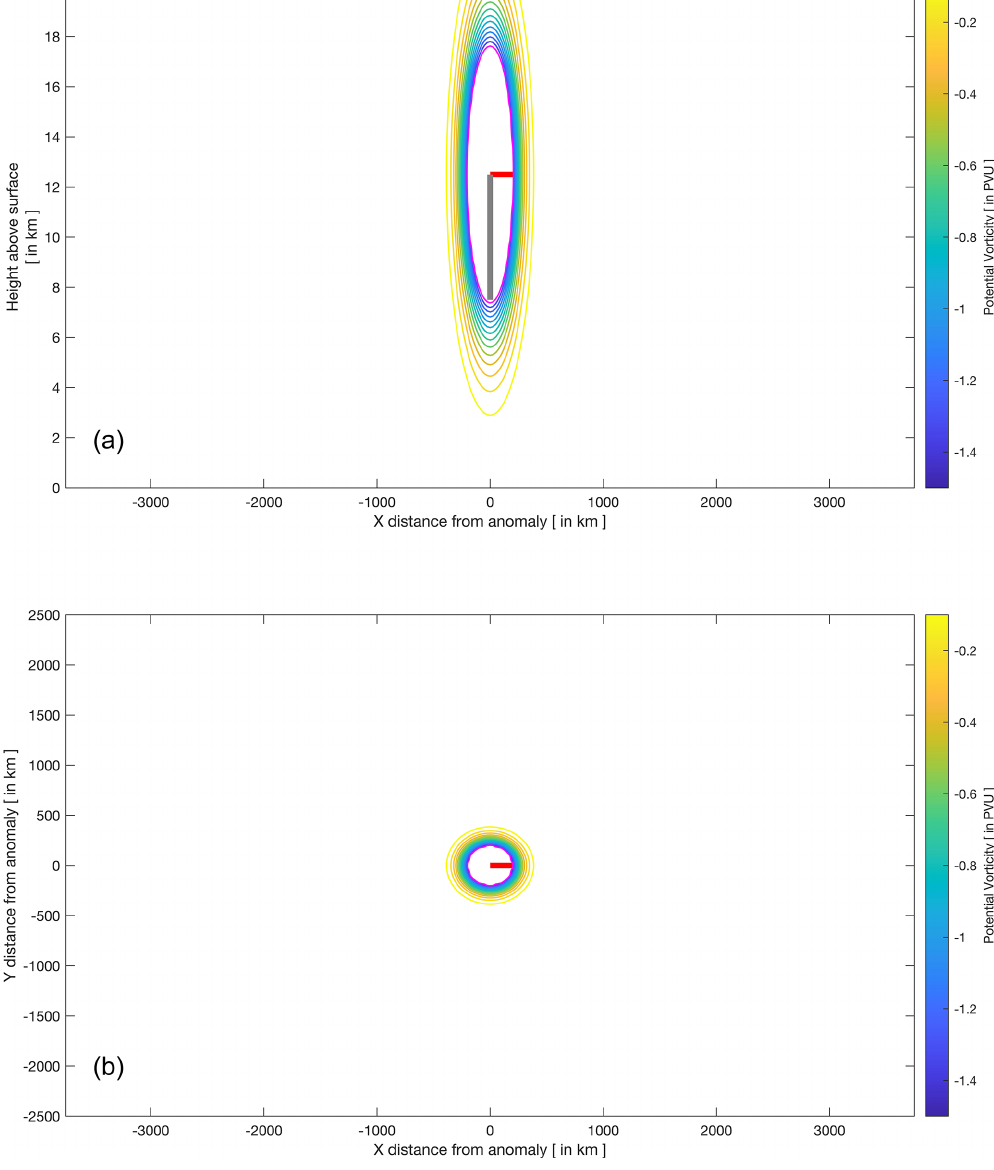
Figure 4. Example of a PV anomaly forced into the idealized domain by means of a longitudinal cross-section (a) and a horizontal cross- section (b) through the centre of the anomaly. The anomaly has a maximum horizontal width along the minor axis of 400km and a height of 10000m. This excludes the “halo” of decreasing values to zero around it. The red line is defined as the anomaly radial width ( x size , y size ), whilst the grey line is defined as the anomaly radial height ( z size ). The anomaly magnitude (in this case − 1.5PVU) is shown by the magenta